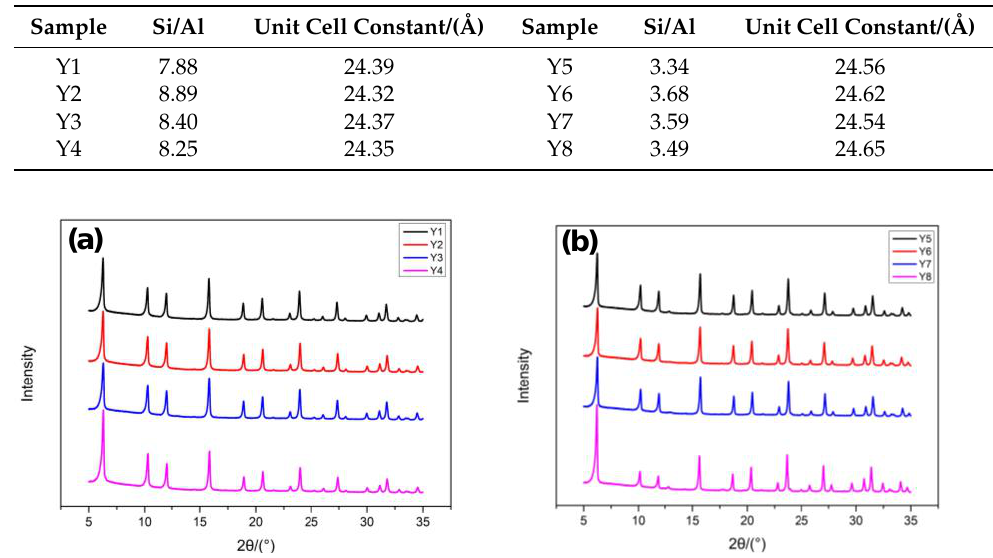
Table 1. Unit cell constant of zeolite Y1 – Y8.